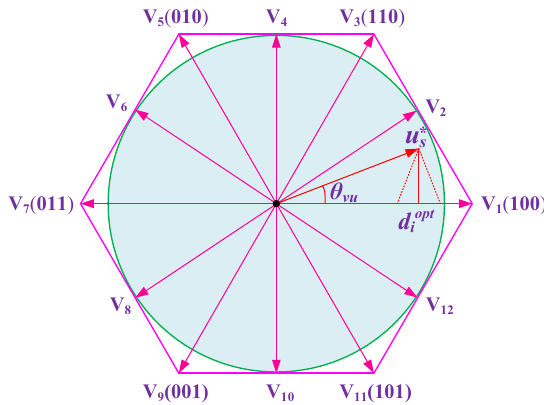
Figure 7. Extended voltage vector control set.